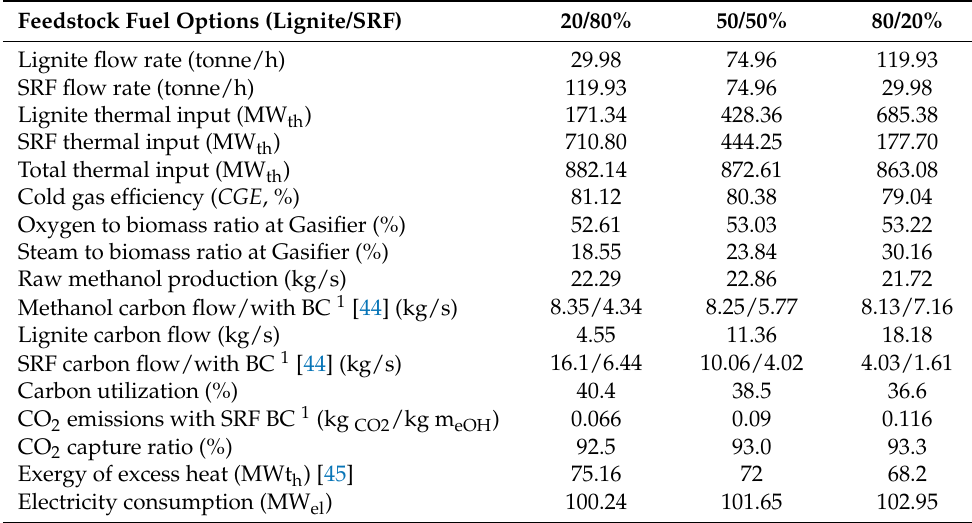
Table 9. Main indicators of the plant’s performance for the three input ratios.